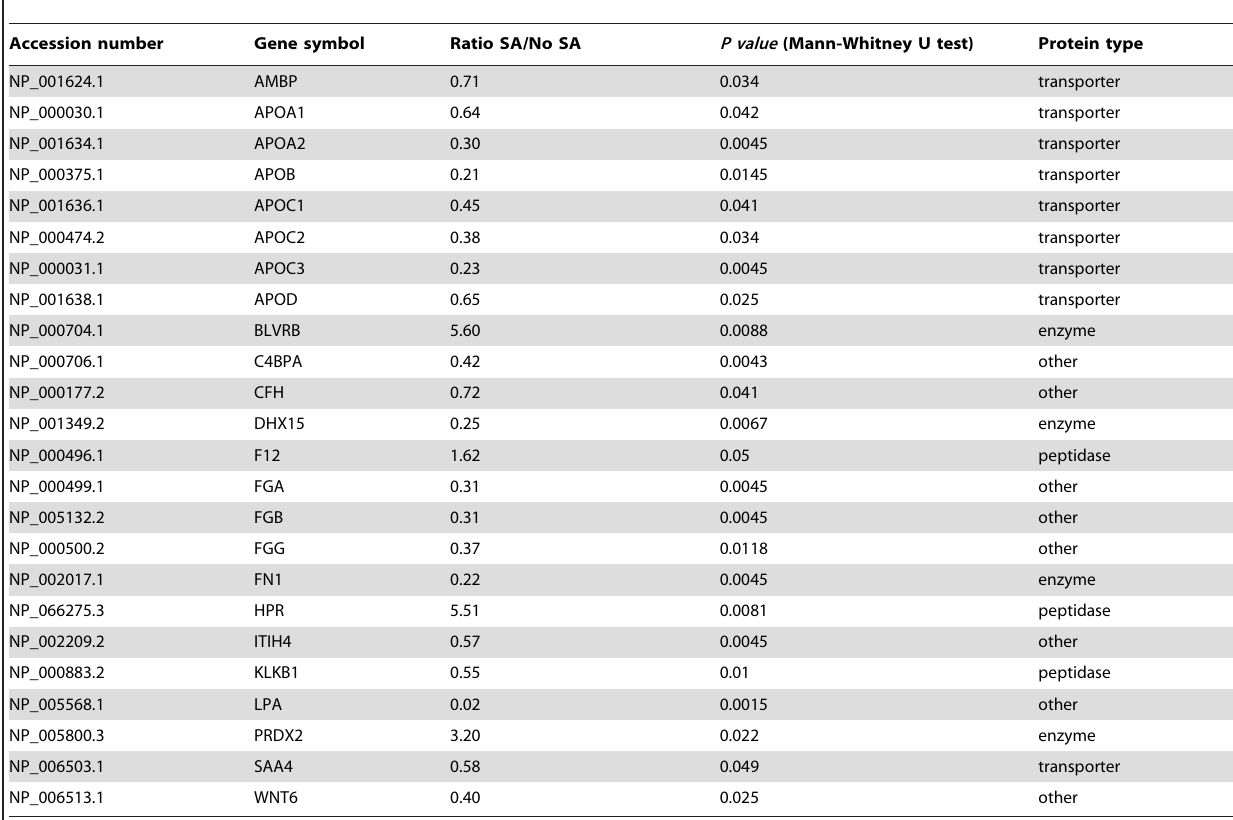
Table 2. Differentially expressed proteins in plasma samples of primigravid women with SA versus those with no SA.